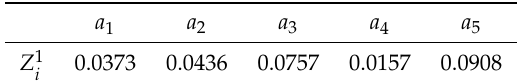
Table 5. Comprehensive evaluation values of five hotels.